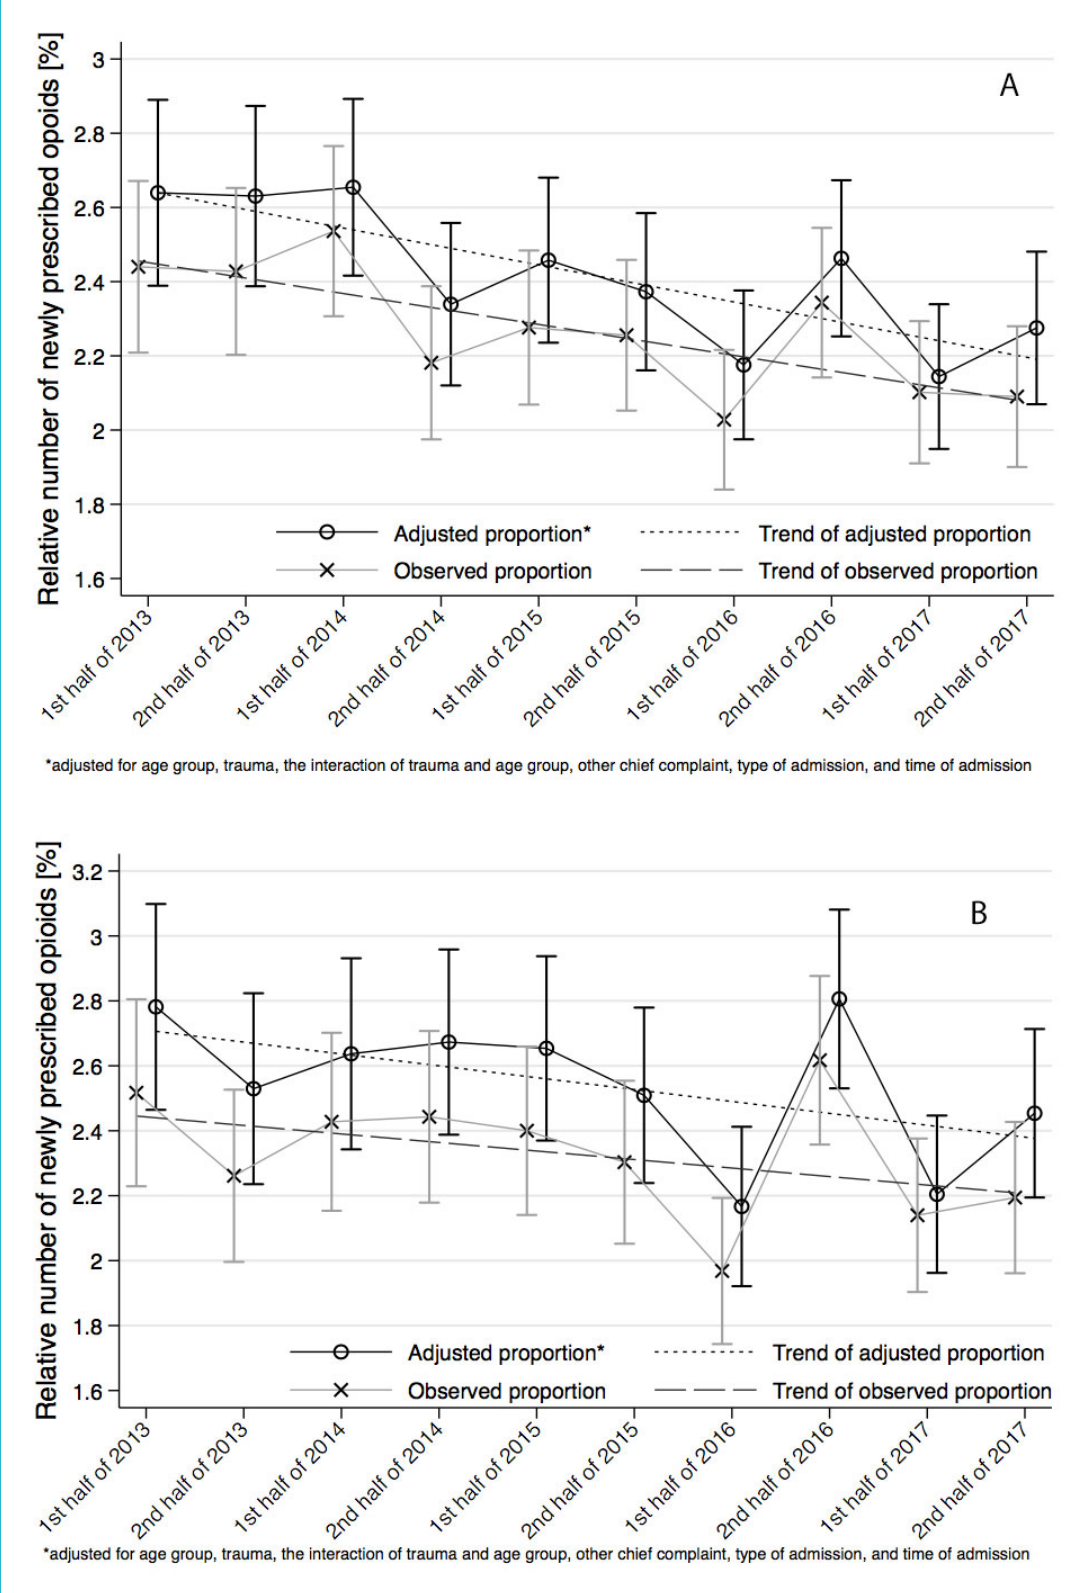
Figure 2: Observed and adjusted relative numbers of incident opioid prescription, i.e., newly prescribed opioids in opioid-naïve patients (A) in all patients, n = 199,299; (B) in outpatients, n = 134,468. The relative number per 6 months with accompanying 95% confidence interval and linear trends are